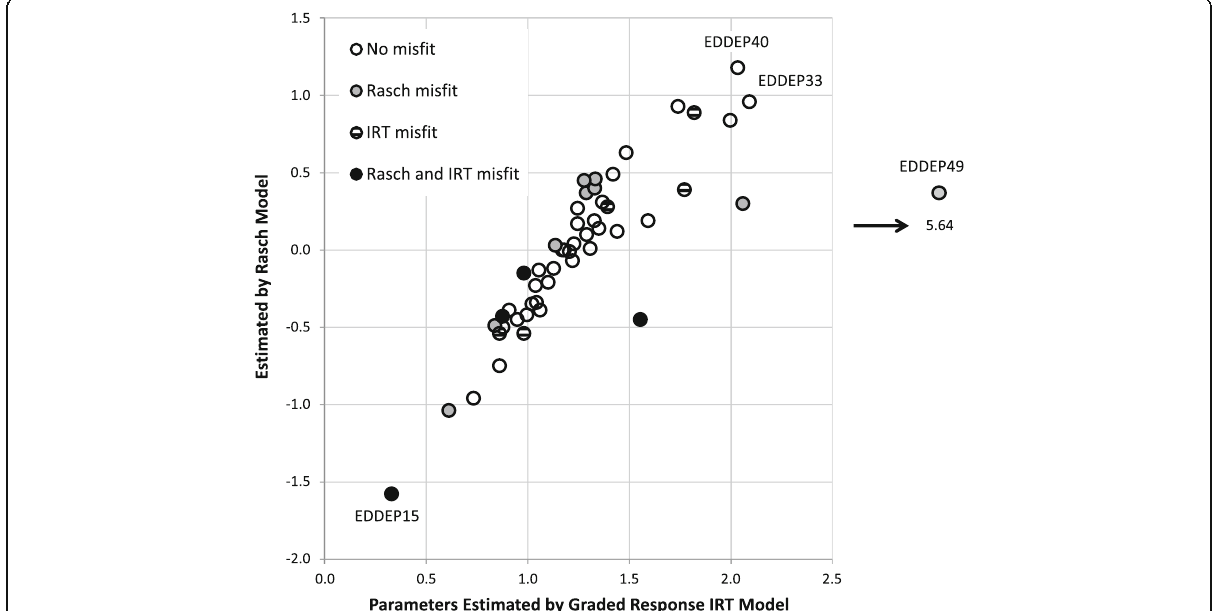
Fig. 3 Location parameter estimates according to Item Response Theory (IRT) and Rasch models, and item misfit. For the both models, the item location is calculated as the average of the threshold parameters for that